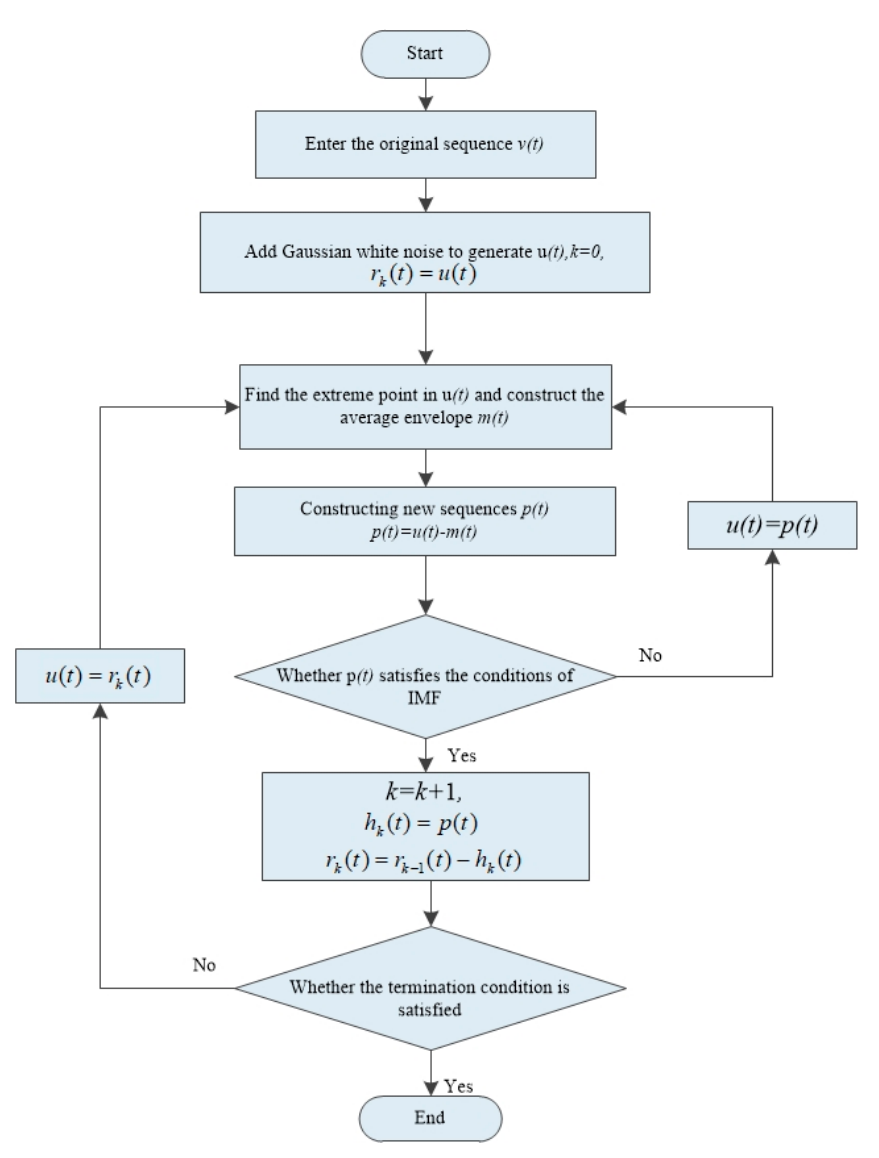
Figure 7. Flowchart of ensemble empirical mode decomposition (EEMD) implementation.